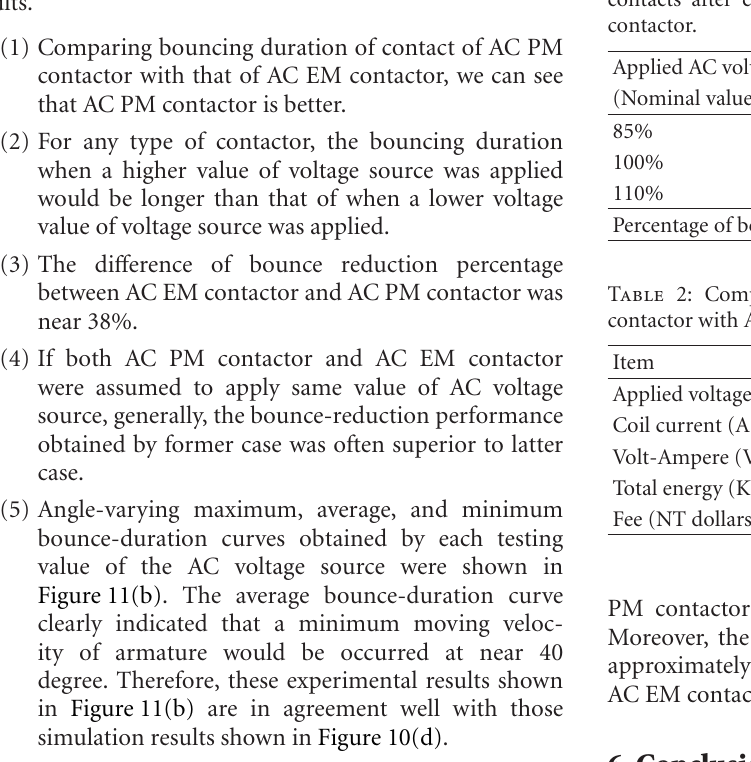
important conclusions are made based on the above testing results.